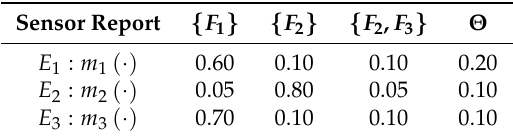
Table 3. BPAs for fault diagnosis of the case study